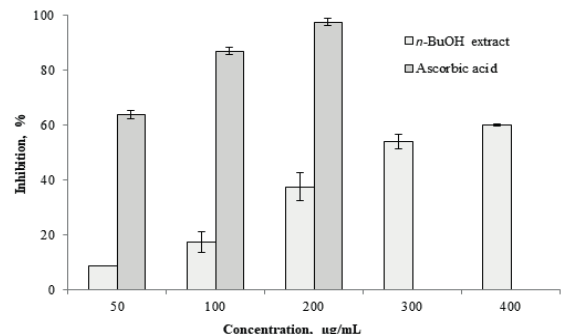
Figure 2 - Inhibition of lipid peroxidation induced by n -BuOH extract of C. sphaerocephala and ascorbic acid.